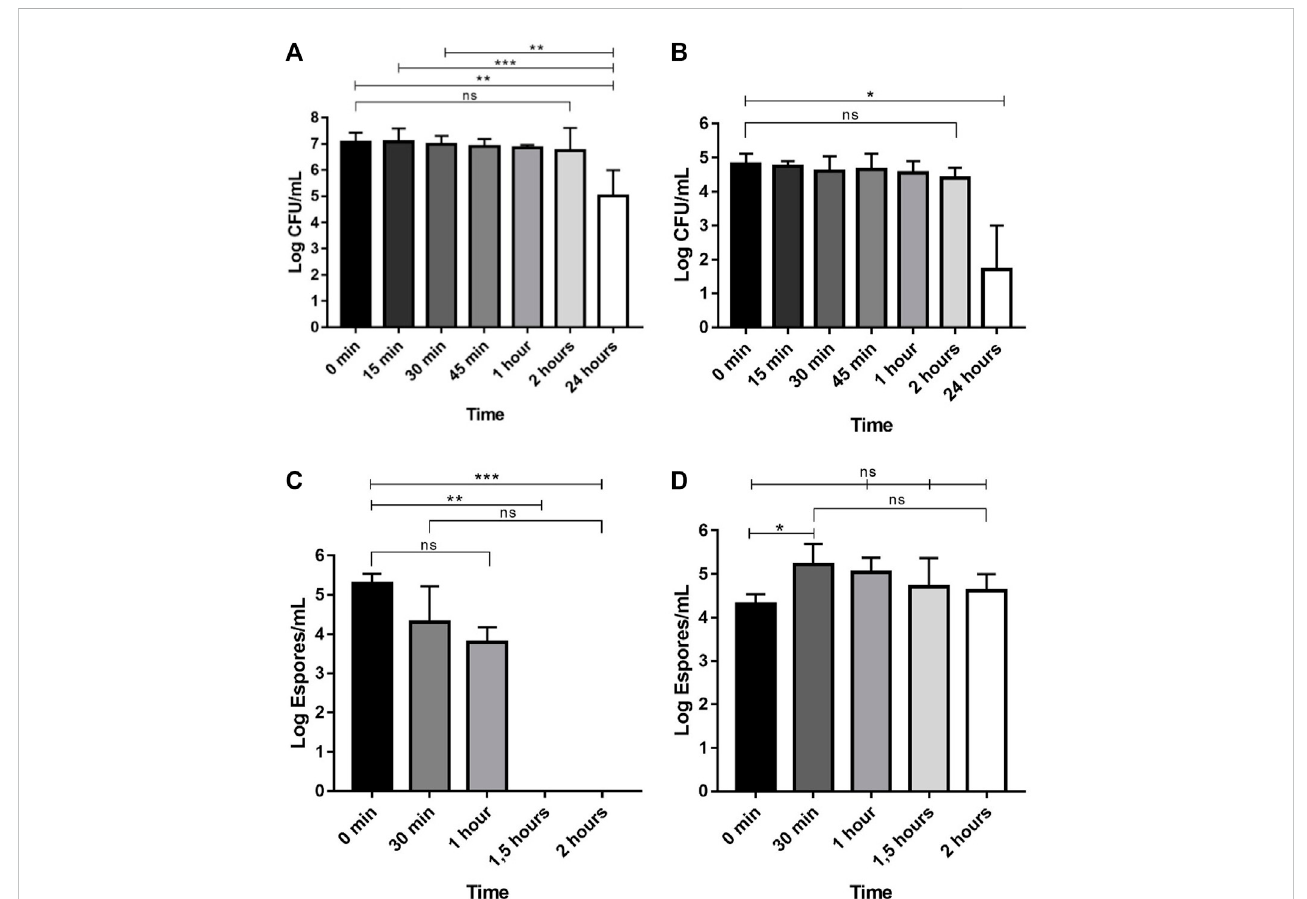
FIGURE 4 Antimicrobial activity of (A) E. coli ; (B) C. albicans ; (C) A. niger ; (D) P. funiculosum after treatment with Ag@ACF fi ltration at different times. The graphs show the median and range data. Data were analyzed by ANOVA using the Kruskal – Wallis test, followed by Dunn ’ s post-hoc multiple comparison test. (n.s =